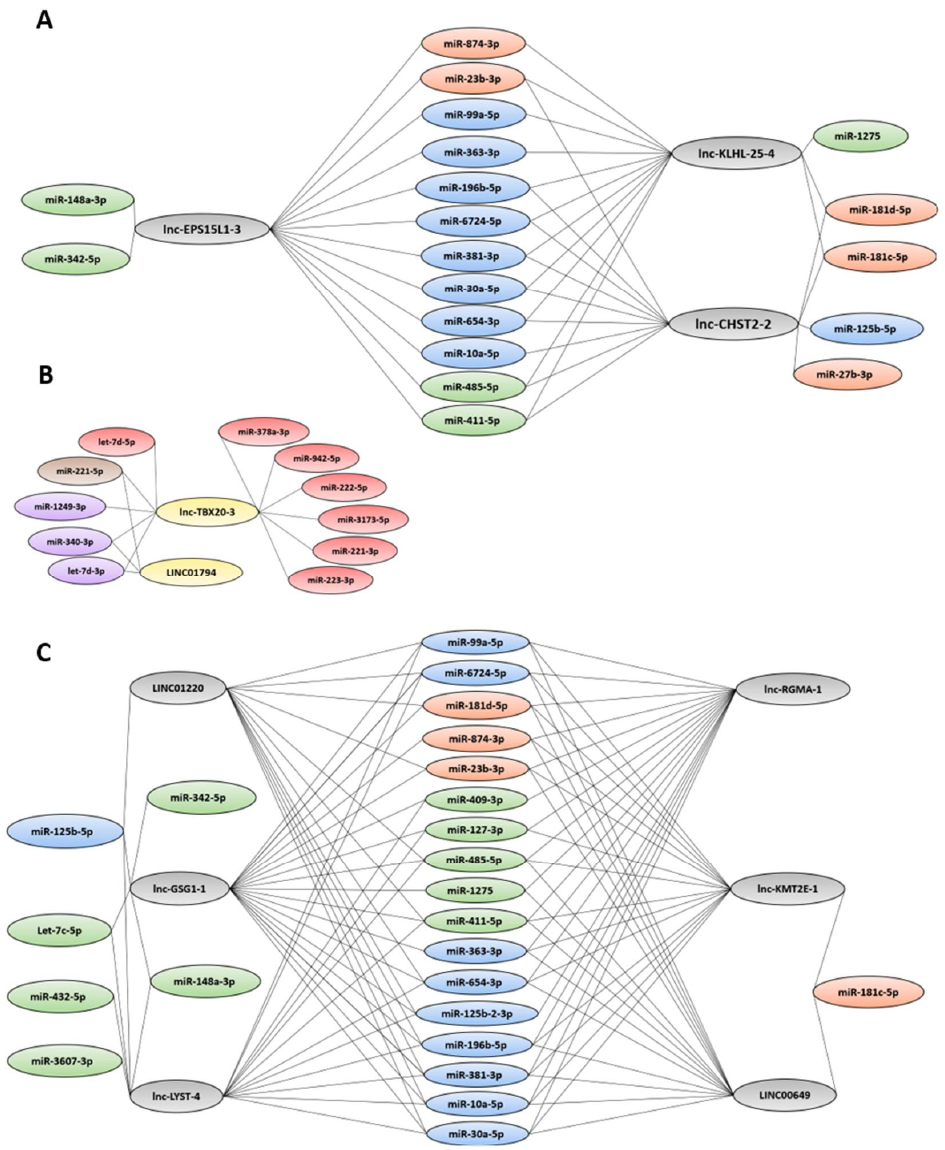
Figure 5. Network of up- ( A ) and downregulated ( B ) LSC DE-lncRNAs and shared DE-lncRNAs ( C ) with anti-correlated miRNAs. Up- and downregulated DE-lncRNAs are represented in grey and yellow, respectively. The anti-correlated miRNAs that are differentially downregulated (|logFC| ≤ 2, Adj. p value ≤ 0.05) in the LSCs, the L-blasts, and the LSCs as L-blasts, in this respective order, are visualized in orange, green, and blue. Upregulated (logFC ≥ 2, Adj. p value ≤ 0.05) DE-miRNAs in the LSCs, L-blasts, and LSCs as L-blasts are visualized in purple, red, and brown